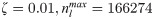
Run-time comparison between FOCAL3D and DBSCAN.Clustering of simulated data of 80 nm clusters (ζ=0.01,nlmax=166274 localizations). A) Run-time scaling of FOCAL3D for varying local volume minC and grid size Δ. B) Scaling of DBSCAN for varying local volume ϵ. C) Scaling of FOCAL3D for a varying number of localizations and at fixed minC = 15 for: Δ = 25 nm (∘), Δ = 45 nm (◊), and Δ = 65 nm (▫). D) Scaling of DBSCAN for a varying number of localizations at: ϵ = 40 nm (∘), ϵ = 70 nm (◊) and ϵ = 100 nm (▫). These values were chosen to roughly match the local volumes used in the FOCAL3D run-time analysis through the relation minC * Δ3 = (4π/3)ϵ3.